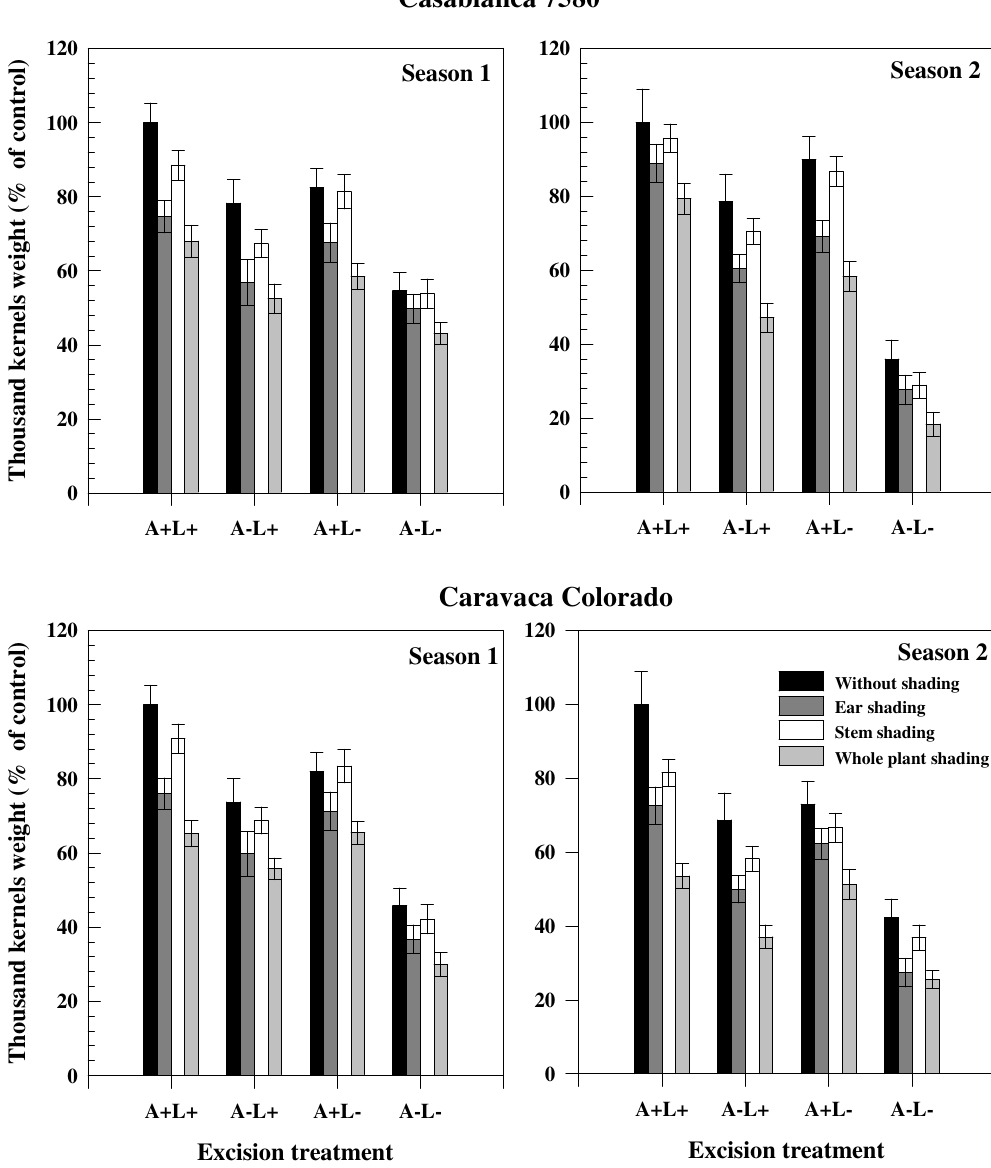
Figure 1. Thousand kernels weight (expressed in % of control plant –without shading and excision) of two durum wheat genotypes grown under rainfed conditions during two consecutive growth seasons. Excision treatments were performed by cutting leaves or awns or both. Shading was done by darkening of spikes (+awns if not excised), stem (+leaves if not excised) or whole